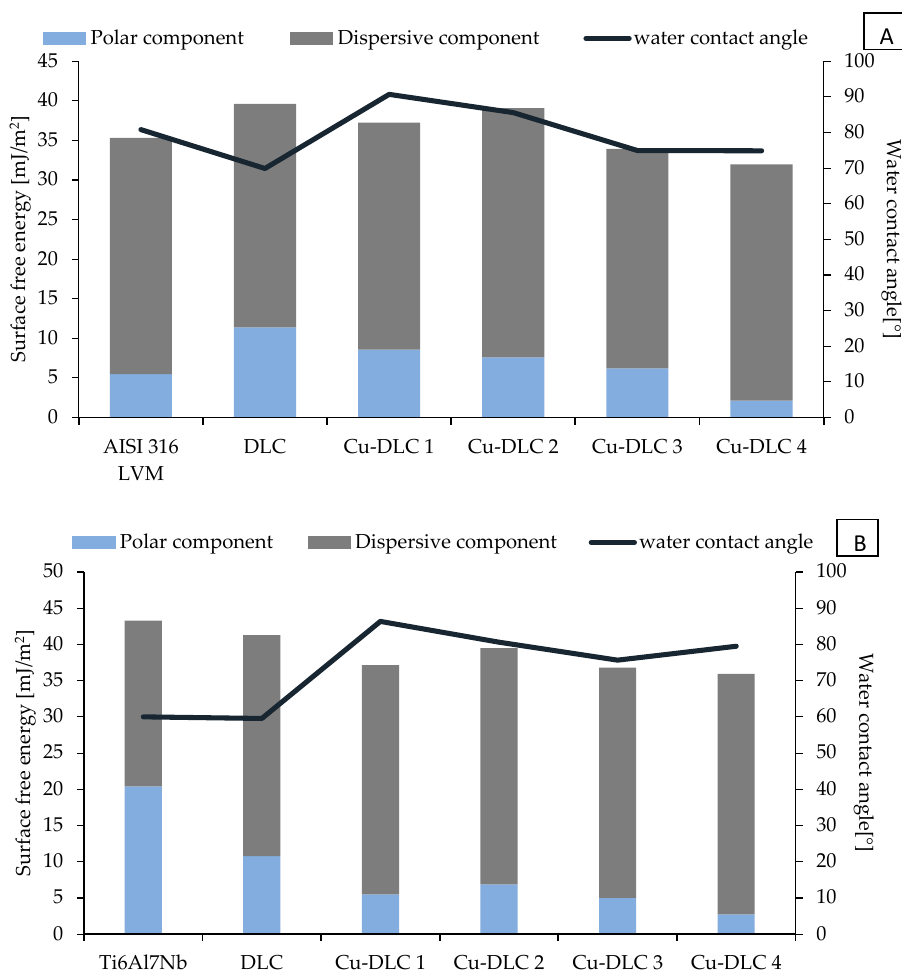
Figure 6. Surface energy components and contact angle for water of Cu-DLC coatings on AISI 316LVM ( A ) and Ti6Al7Nb ( B )